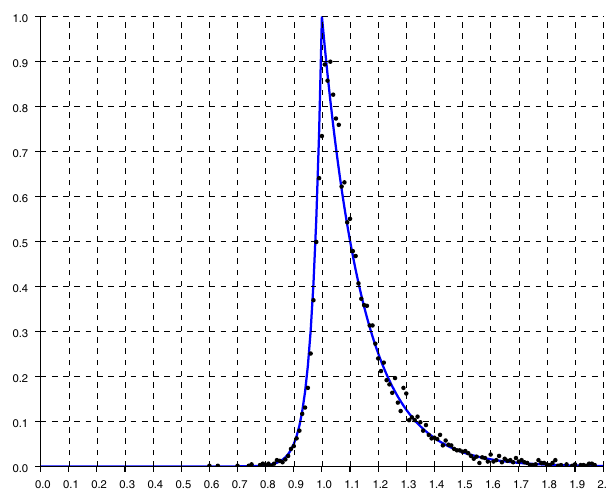
Figure 4. Histogram of the ratio of reported to actual distance based on about 10,000 measurements (scaled so that the peak equals one). The solid line is the “double exponential” parametric fit.